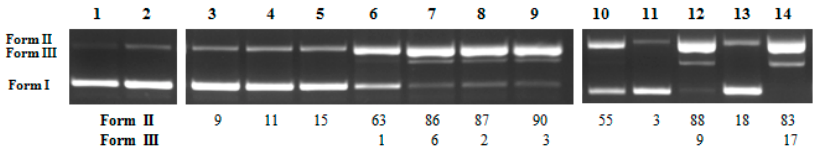
Figure 3. DNA photo-cleavage by various oxime ester conjugates at concentration of 100 μ M with plasmid DNA pBluescript KS II, at 312 nm for 30 min. Top: Gel electrophoresis picture: Lane 1: DNA without UV irradiation; Lane 2: DNA with UV irradiation; Lanes 3–9: DNA + amidoximes or ethanone oxime derivatives ( 6 , 7 , 8 , 10 , 12 , 5 , and 11 , respectively) + UV irradiation; Lanes 10–14: DNA + aldoxime derivatives ( 17 , 18 , 19 , 20 , and 21 , respectively) + UV irradiation; Bottom: Calculation of the % conversion to ss (Form II) and ds (Form III) damage.